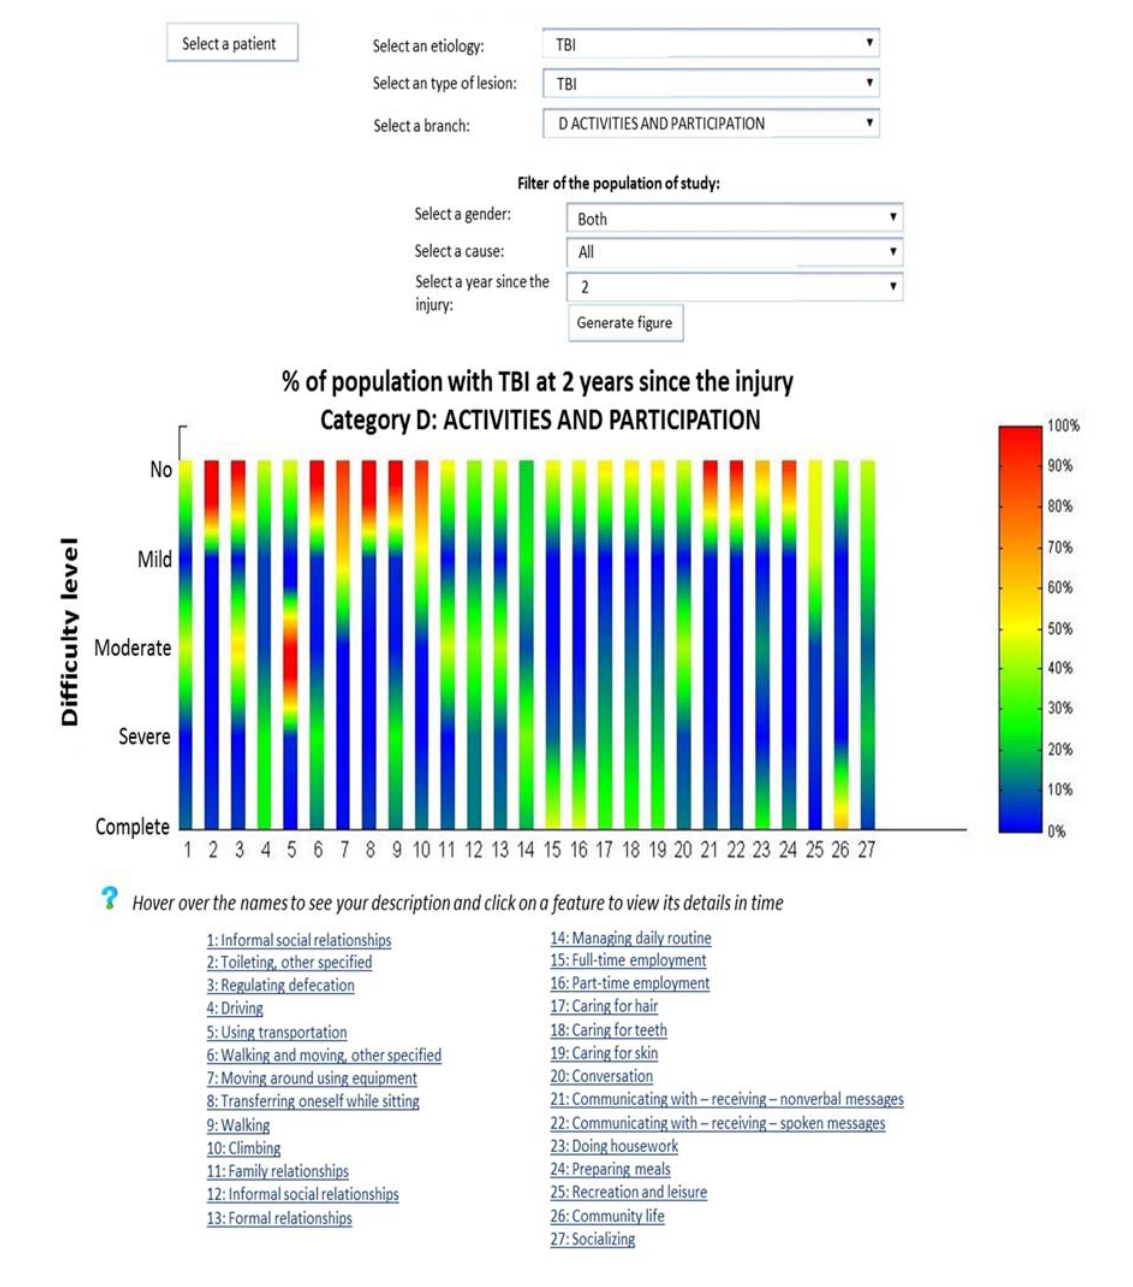
Figure 3. Graphical representation of the situation of the population of traumatic brain injury (TBI) and individuals through the ICF